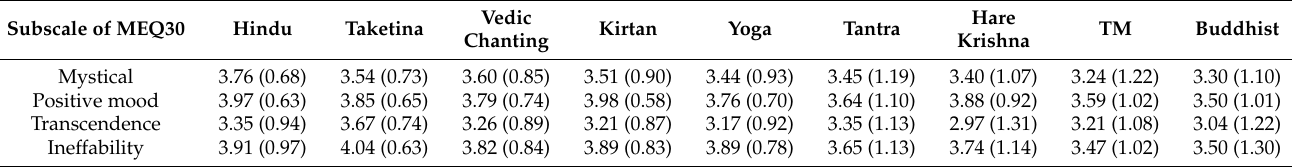
Table 2. Revised mystical experience questionnaire (MEQ30) subscale mean and standard deviation (in parentheses) scores by tradition.